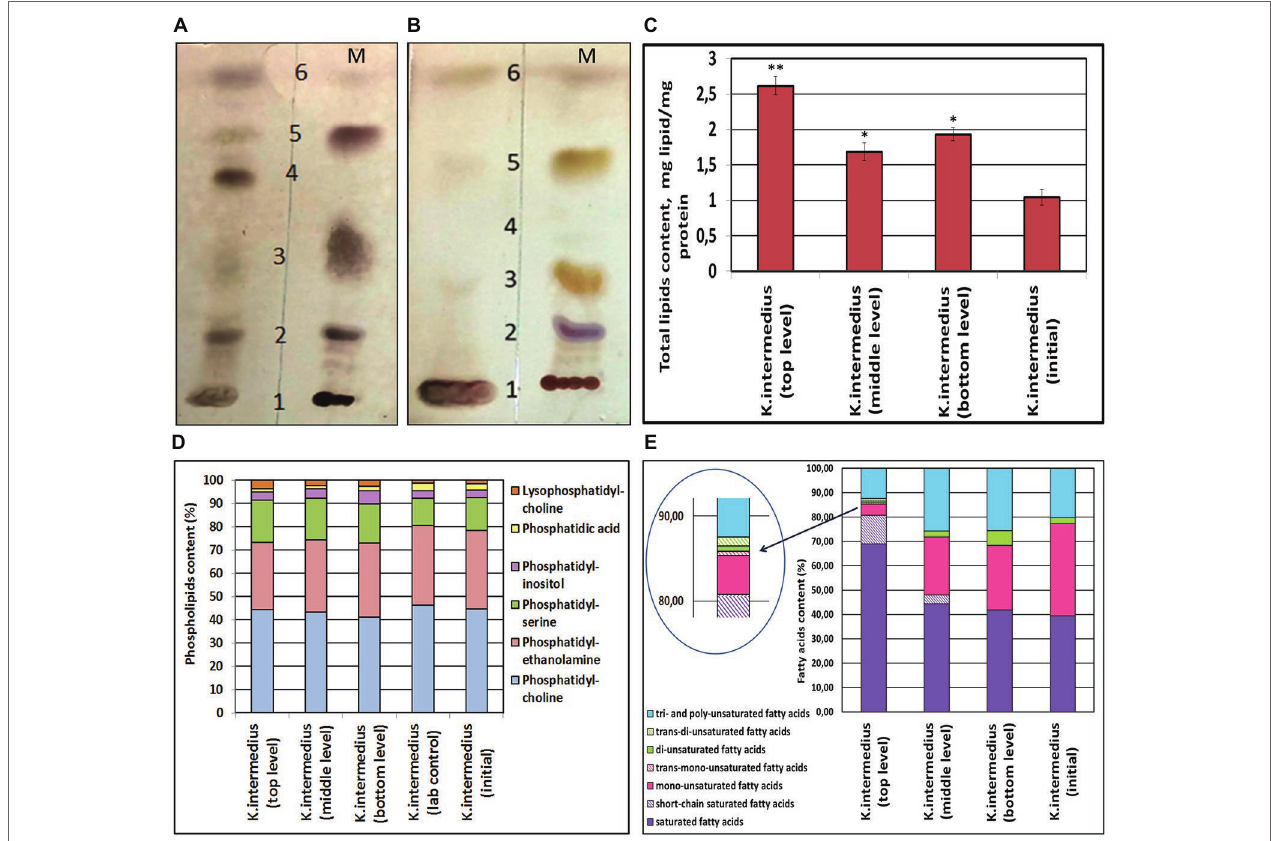
FIGURE 2 | Classes of lipids of OMVs of bacterial monocultures Komagataeibacter intermedius (A,B) ; alterations in the lipid content in OMVs of K. intermedius strains recovered from post-spaceflight kombucha microbial cultures (KMC) (C,D) . (A) Representative thin layer chromatography separation of lipids isolated from OMVs of K. intermedius IMBG185 recovered from the top level of the exposure platform (on the left); on the right–lipid markers (M): 1 – phospholipids (PLs); 2 – sterols; 3 – 1,3-diglycerides; 4 – free fatty acids; 5 – triglycerides; 6 – sterol ethers. (B) Lipids of OMVs of initial K. intermedius IMBG180 (on the left); on the right– markers (M). (C) Content of total lipids in OMVs of K. intermedius strains of post-spaceflight KMCs. (D) PLs of OMVs of K. intermedius strains of post-spaceflight KMCs. (E) Content of fatty acids in OMVs of K. intermedius strains of post-spaceflight KMCs. Three replicates were used in the experiments on lipid content measurements. Data were shown as mean ± SD ( n = 3). * p ≤ 0.05; ** p ≤